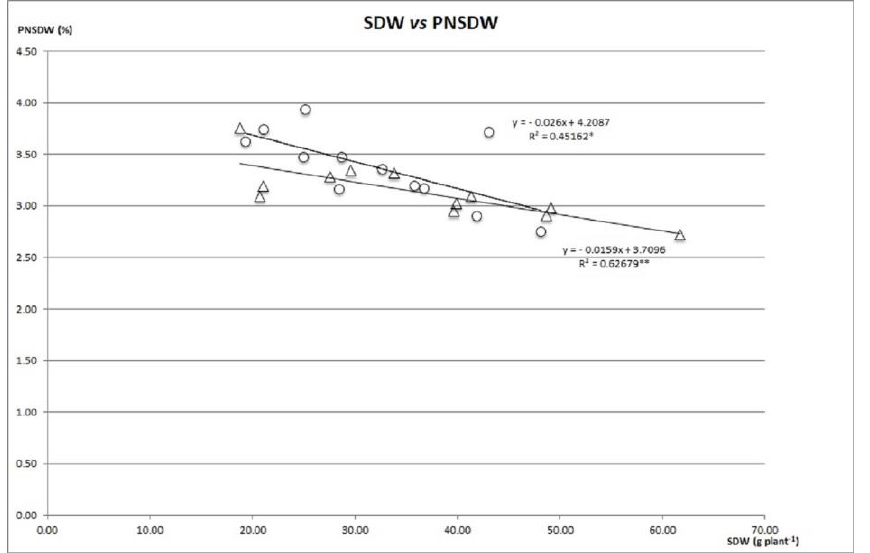
Figure 3. SDW vs. PNMSA ratio of genotypes PHA-0683 and PMB-0220 under irrigation in field. ** p < 001 and * p < 0.01.